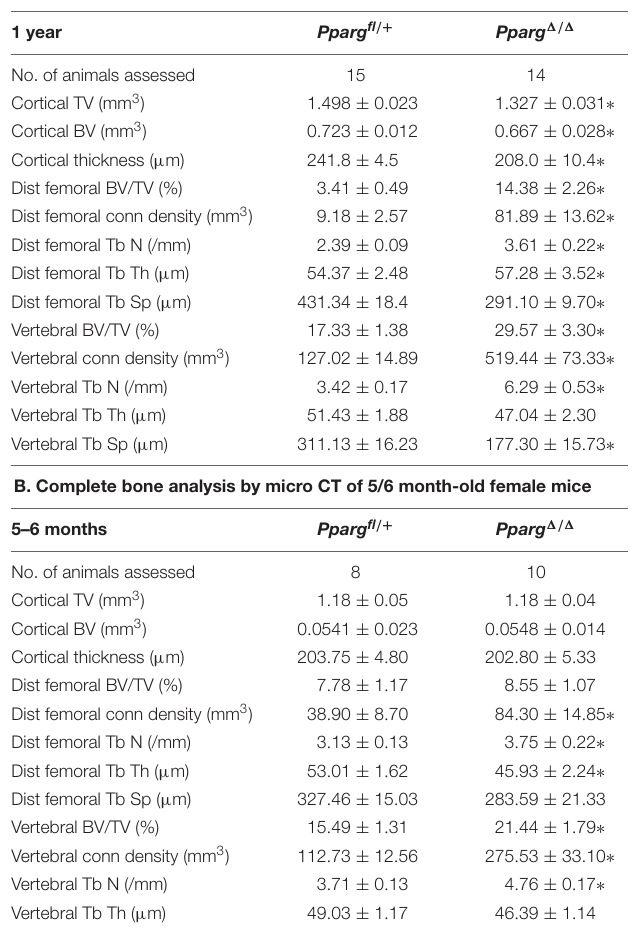
TABLE 1 | (A) Micro-CT data were obtained from various bones in Pparg fl / + and Pparg (cid:49)/(cid:49) of 1 year-old female mice. (B) Similar evaluation of bones from 5/6 month-old female